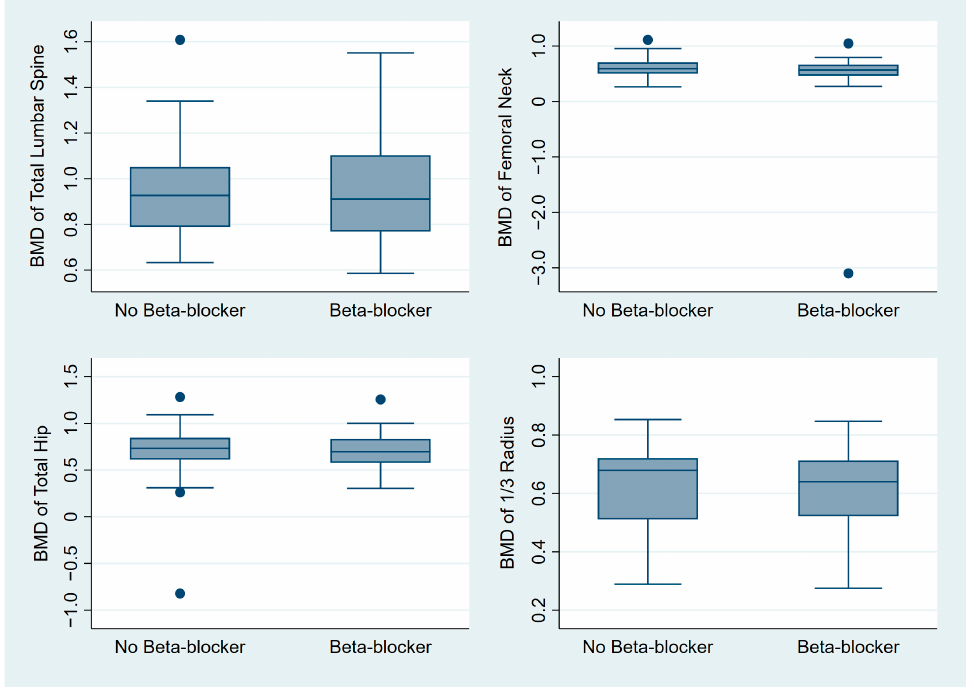
Figure 1. Box plot graphs comparing the BMD between the beta-blocker and control groups. Abbreviation: BMD, bone mineral density.